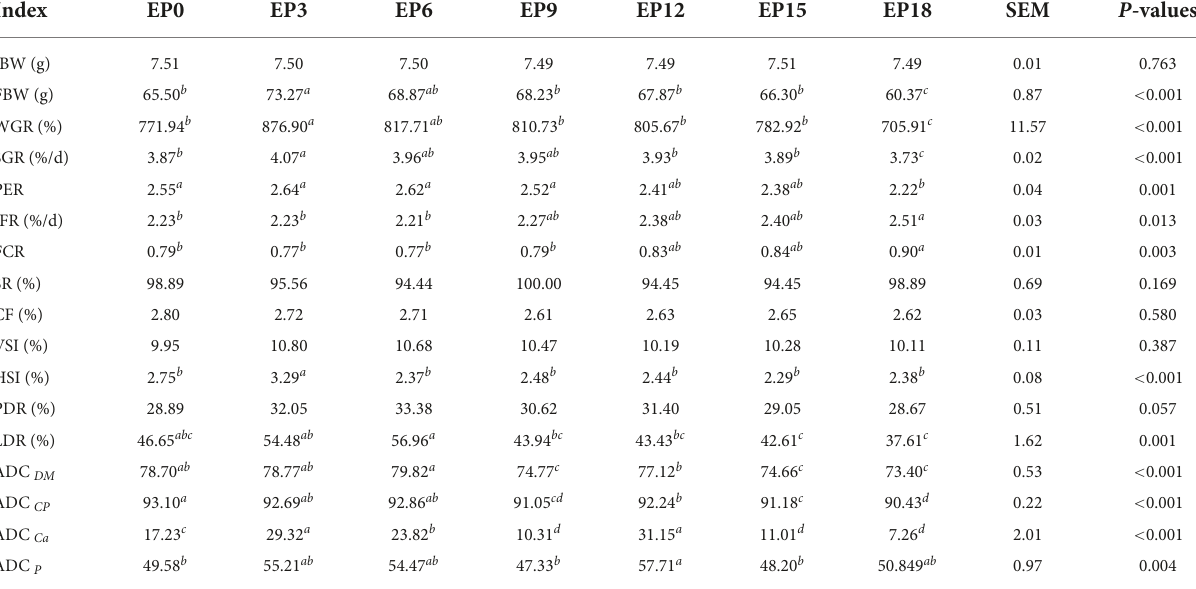
TABLE 3 Growth and apparent digestibility coefficients of hybrid groupers fed with